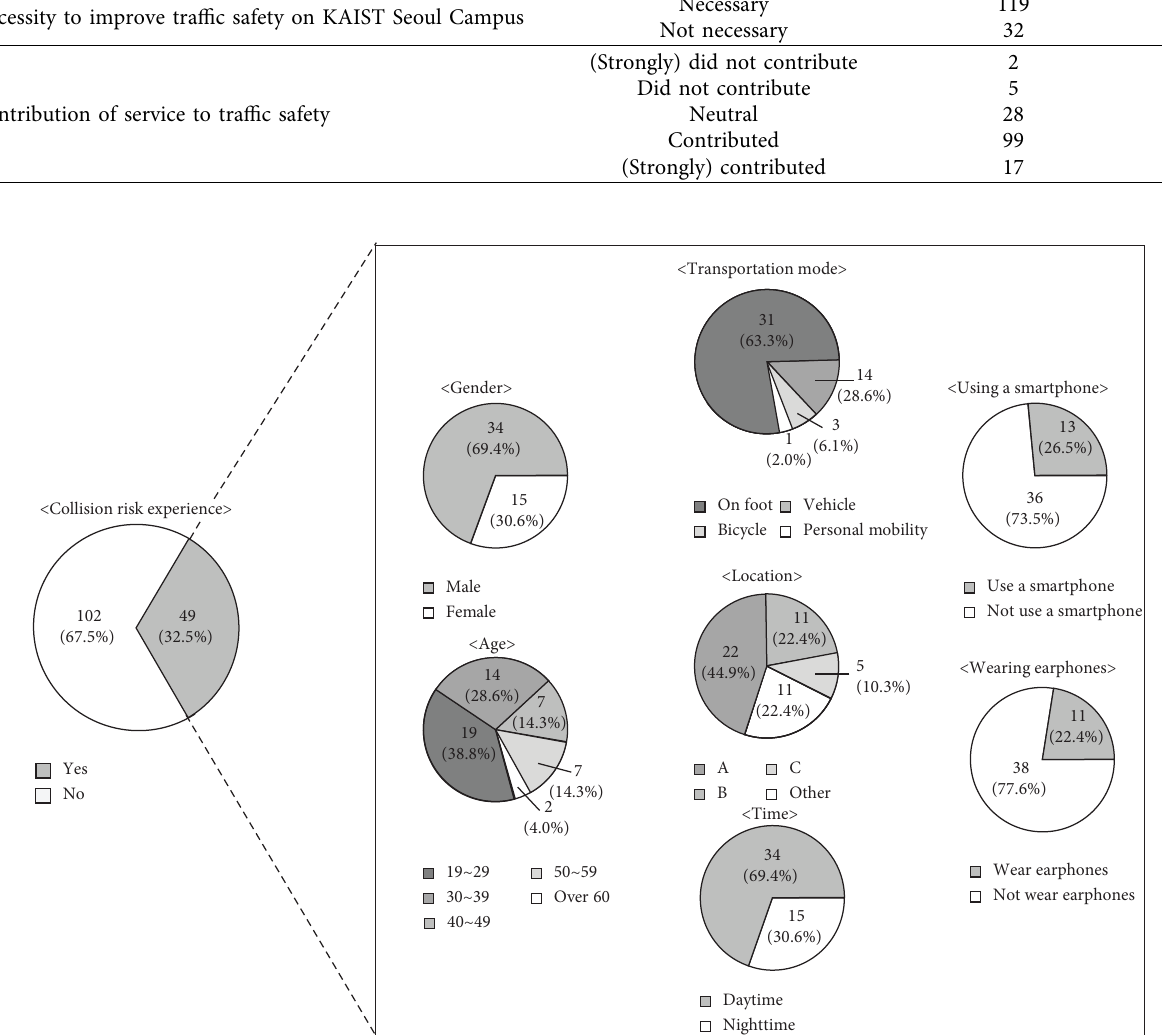
Figure 10: Responses to questions about collision risk. Respondents who experienced risk were asked seven diferent